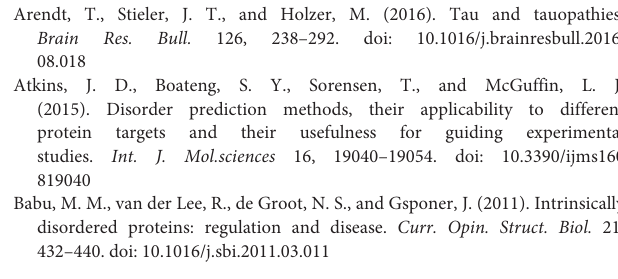
FIGURE S1 | Disorder prediction from different algorithms. The average of slope values from all selected algorithms for full-length tau and all selected regions (NTR, PRR, MBR and CTR) are shown. Regions are color-coded as shown in Figure 2 . Note, that NTR and PRR mainly show an increase in disorder, while the disorder of the CTR decreased. FIGURE S2 | Comparison of average predicted disorder of tau sequences and its parts for the most represented taxons (i.e., bony fish, birds and mammals, color-coded from yellow to orange). (A) Boxplots for all selected disorder prediction algorithms are shown. The background color corresponds to regions of tau as shown in Figure 2 . Statistical significance was derived from Mann–Whitney test. ∗ p < 0.05, ∗∗ p < 0.01, ∗∗∗ p < 0.001. (B) Numbers of differentially changed disorder for tau sequences divided into regions in selected taxons is shown. Here, table for one level of significance is shown, p -value < 0.05. Note that MBR shows a continuous increase in disorder (MBR), NTR and full-length tau mostly show increase from fish to birds and from fish to mammals, however, in some cases a decrease in disorder from birds to mammals was prominent and finally, CTR shows a continuous decrease in predicted disorder. FIGURE S3 | Comparison of numbers of predicted phosphorylation sites of tau and its regions for most represented taxons (i.e., bony fish, birds and mammals; color-coded from yellow to orange). (A) Boxplots for phosphorylation of tau and its regions are shown. The background colors and filling colors of boxplot correspond to the residue that was predicted to be phosphorylated (all sites—light gray, serine residues—turquoise, threonine residues—dark yellow and tyrosine residues—magenta). Statistical significance was derived from Mann–Whitney U test. ∗ p < 0.05, ∗∗ p < 0.01, ∗∗∗ p < 0.001. (B) Comparison of numbers of predicted phosphorylation sites of tau sequences and its parts for most represented taxons (i.e., bony fish, birds and mammals). Numbers of differentially changed disorder for tau sequences divided into regions in selected taxons is shown. Here, table for one level of significance is shown, p -value <